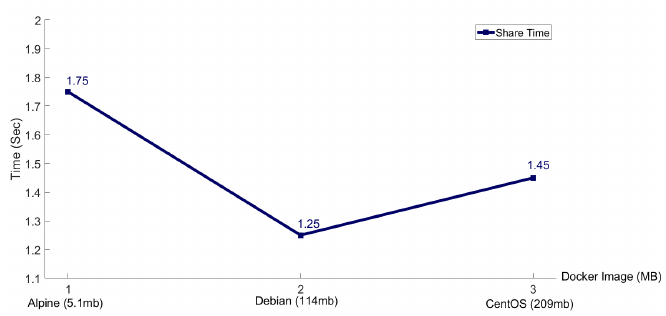
Figure 6. Comparison of shared time with Alpine, Debian and CentOS.